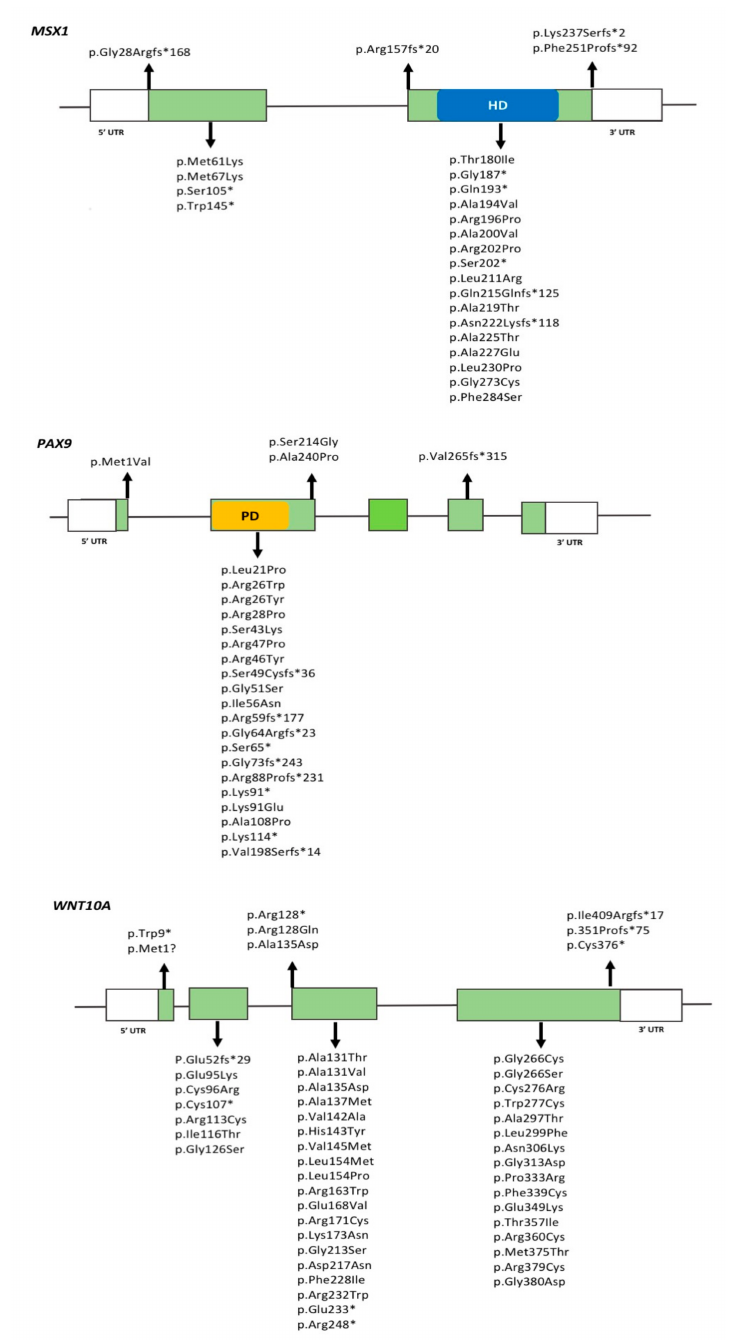
Figure 1. Location of predicted missense, frameshift, and nonsense mutations in MSX1, PAX9 , and WNT10A genes. Green boxes represent exons, horizontal lines between exons represent introns. HD, corresponds to homeodomain in MSX1 . PD, corresponds to paired domain in PAX9 . UTR: Untranslated